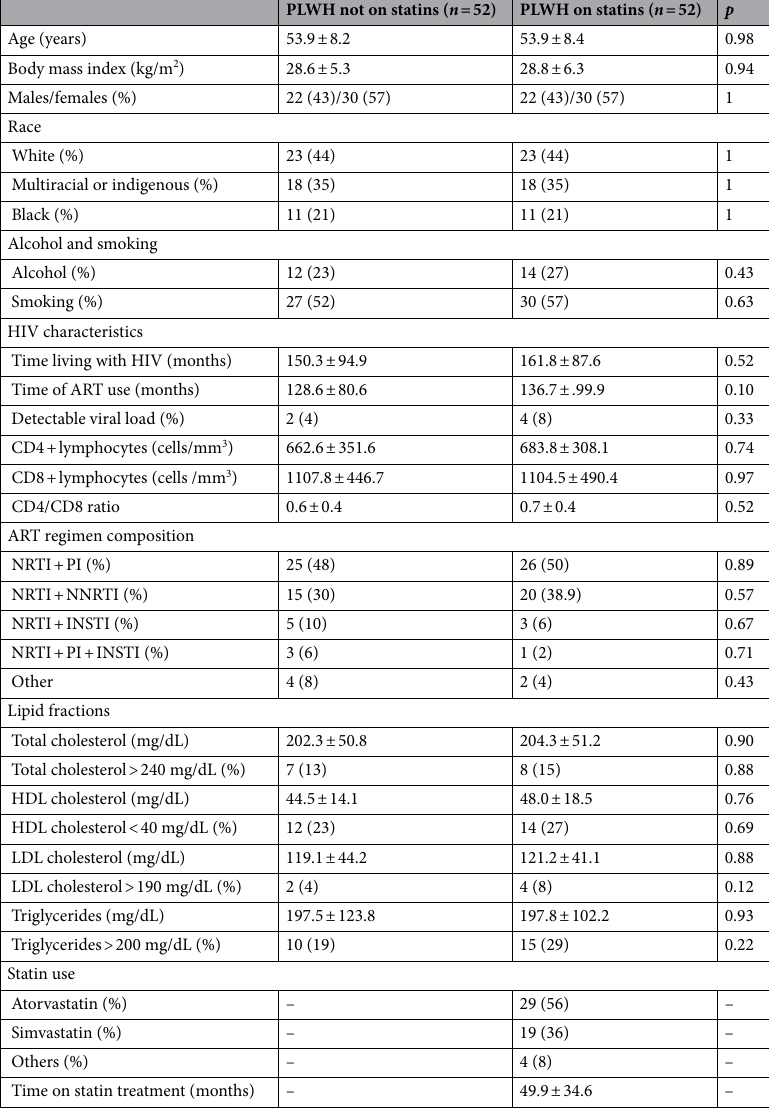
Table 1. Participants’ characteristics. Values in the table are mean ± standard deviation when variables are continuous; and number and (%) when variables are categories. Continuous variables are expressed as mean ± standard deviation, and categorical variables are expressed as absolute (relative) values. Lipid fractions are “on treatment” lab values. PLWH people living with HIV, ART antiretroviral therapy, CD4 HDL high-density lipoprotein, LDL low-density